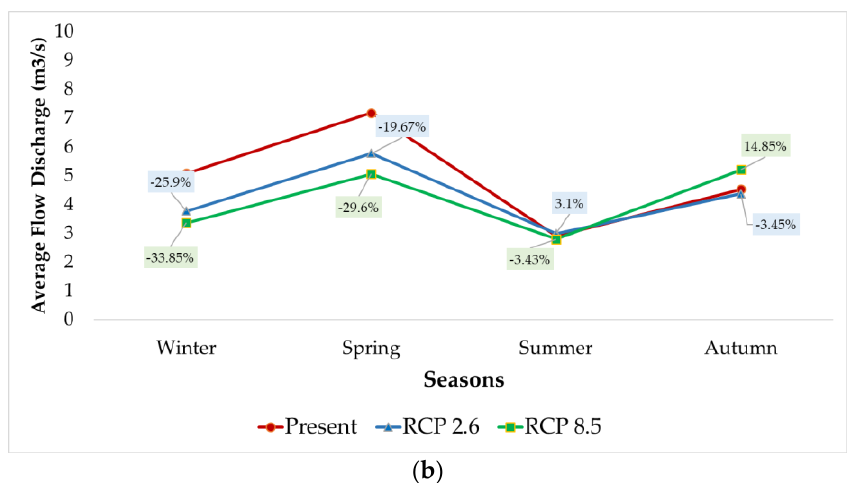
Figure 8. ( a ) Monthly and ( b ) seasonal average discharge simulation for present and near future periods.